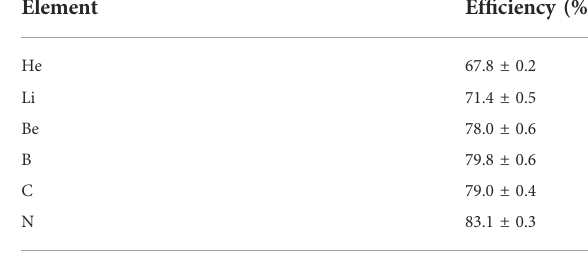
TABLE 2 Integrated ef fi ciencies for fragments with different